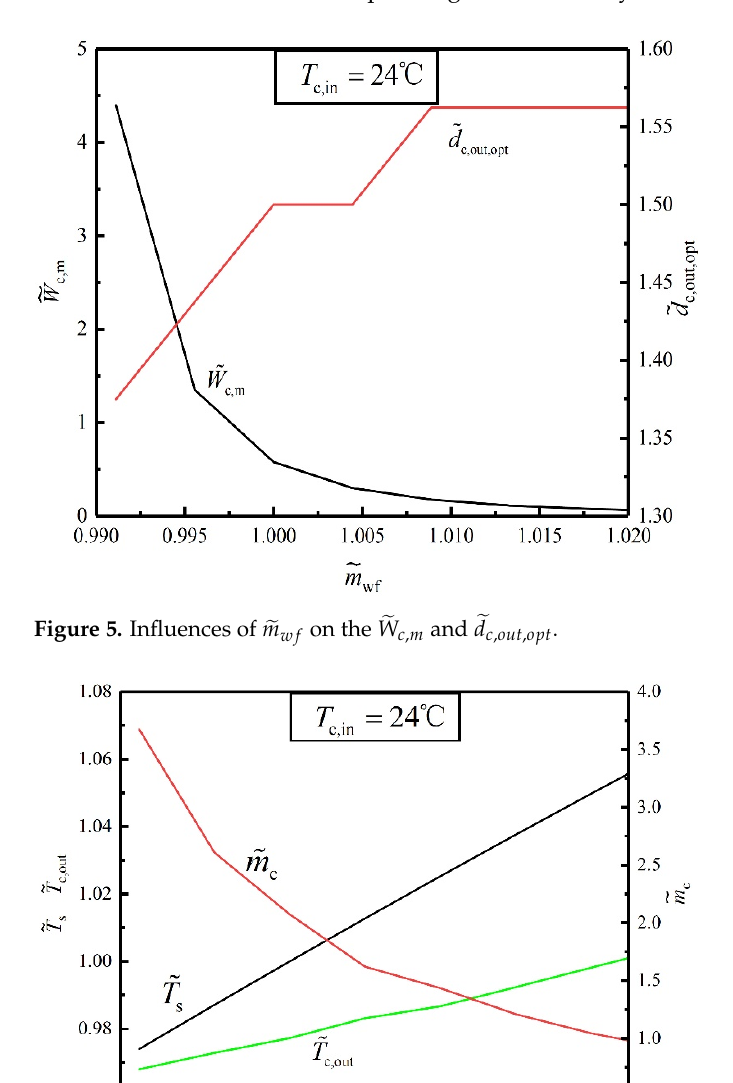
d  . W  and T on the relationship between Figure 4. Influence of , c out c , c in T on the relationship between the di ‐ 202 , c in W  of the condenser and dimensionless tube diameter . From Fig. 203 mensionless TPP c Figure 5 shows the influences of the dimensionless MFR (cid:101) m wf on the minimum dimen- d  , the dimensionless TPP of the 204 , c out sionless TPP (cid:101) W c , m and optimal dimensionless tube diameter (cid:101) d c , out , opt . Figure 6 shows the 22 T C   is lower than those with the other discussed two 205 , c in influences of the dimensionless MFR (cid:101) m wf on the dimensionless CT (cid:101) T s , outlet temperature W  rises gradually for the 206 T , the corresponding temperatures. With the rise of CWIT c , c in (cid:101) T c , out and MFR (cid:101) m c of the CW at minimum TPP condition. Figure 5 illustrates that with d  T reduces the MTD of the conden ‐ 207 same the increase of (cid:101) m wf , (cid:101) W c , m decreases gradually, (cid:101) d c , out , opt increases as a whole, (cid:101) T s and (cid:101) T c , out , c out , c in increase, and (cid:101) m c decreases. This is because under certain HL, the increase in steam MFR 208 will inevitably lead to the decrease in condensation latent heat of the steam, and eventually 209 the CT increases. When the MTD and HL are constants, the increase in CT will inevitably 210 lead to the increases of average temperature and outlet temperature of the CW, and the MFR of the CW and the corresponding TPP ultimately reduce.